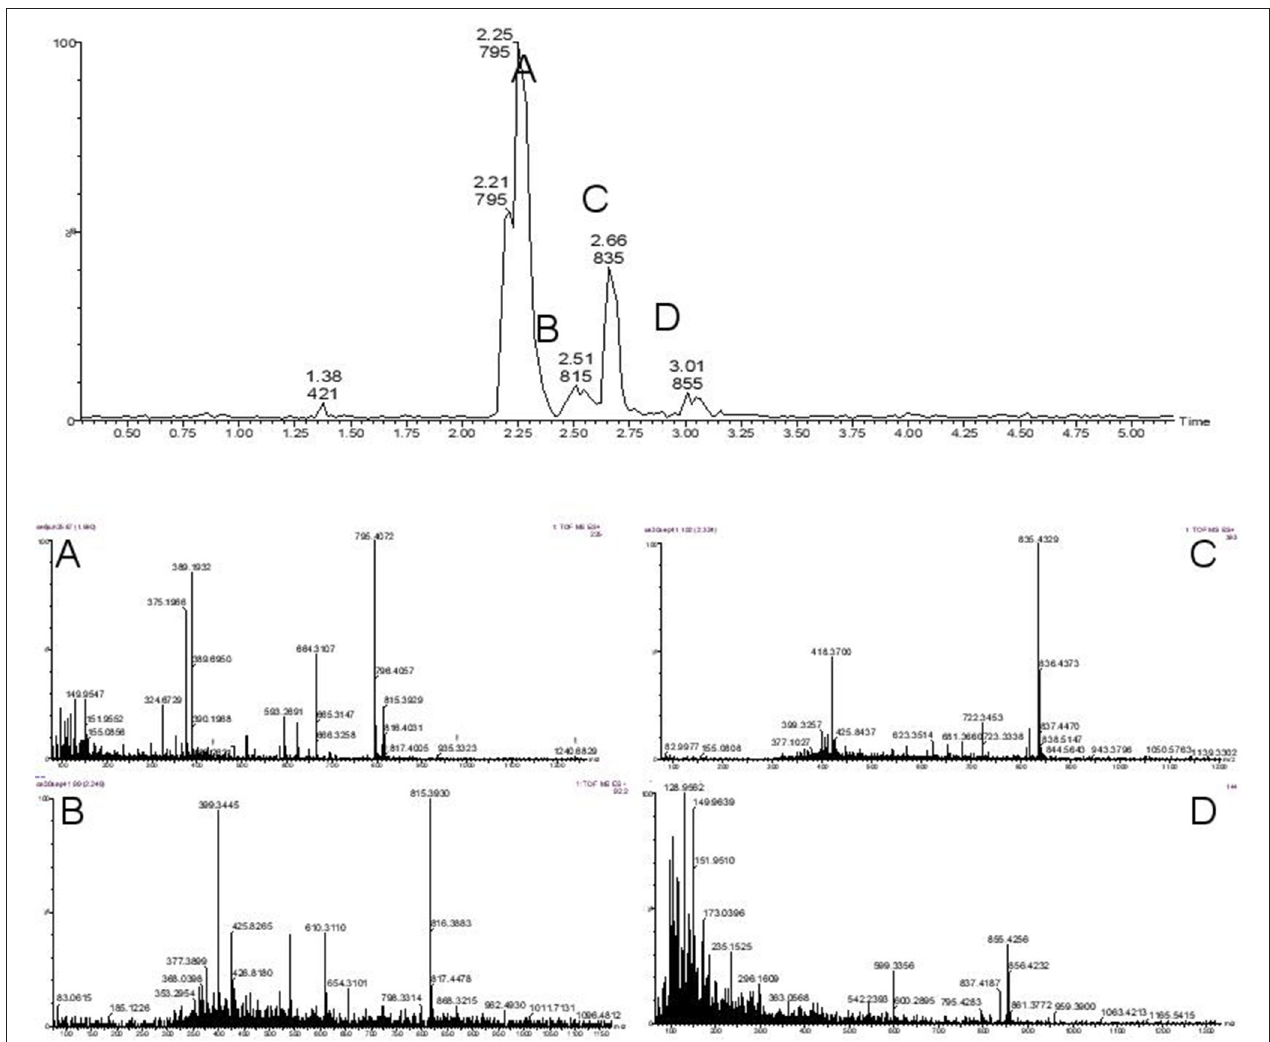
FIGURE 3 | Identification of four commonly observed degradation intermediates of MC-LR during treatment with ozone microbubbles. The expanded mass chromatogram shows four clear peaks A with isomers m/z 795, B m/z 815, C m/z 835 and D m/z